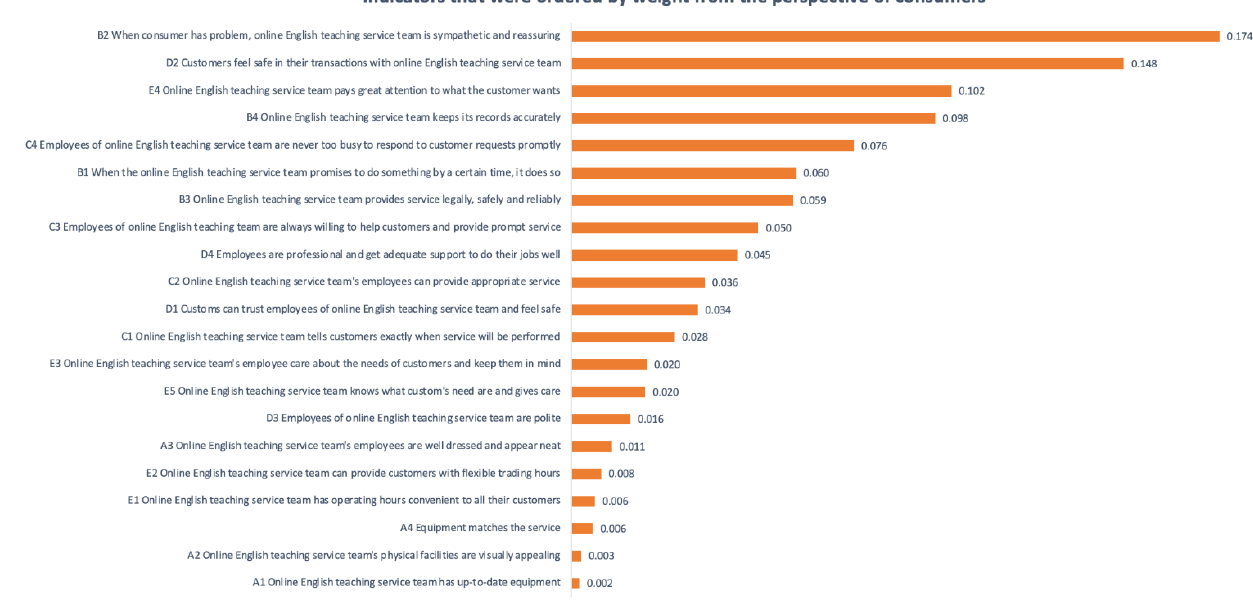
Figure 4. Indicators that were ordered by weight from the opinion of service providers.